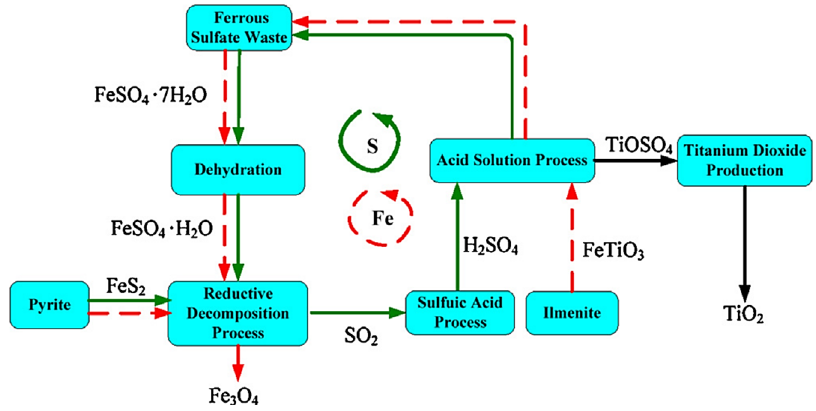
Figure 3. Recycling sulfur and iron from ferrous wastes [65] (with permission from Elsevier, copyright year 2022).